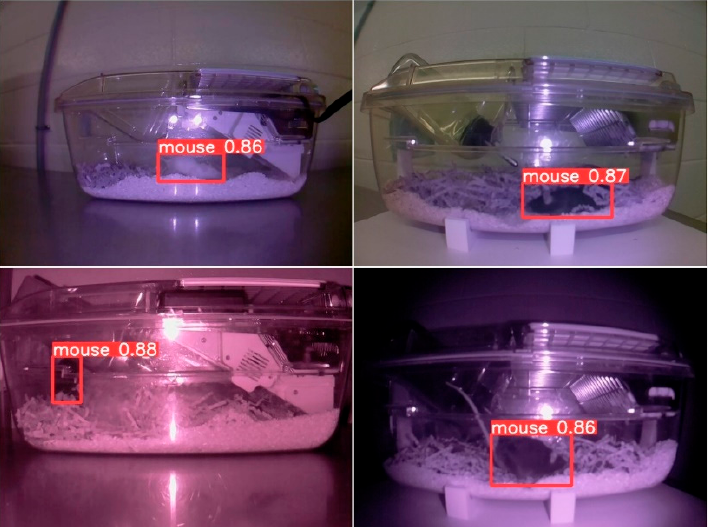
Figure 4. Sample outputs are generated by the neural network. One can see the confidence level of the neural network for each detected mouse bounding box. The top left image shows a white mouse, while the rest are black. Different lighting conditions are illustrated as well.